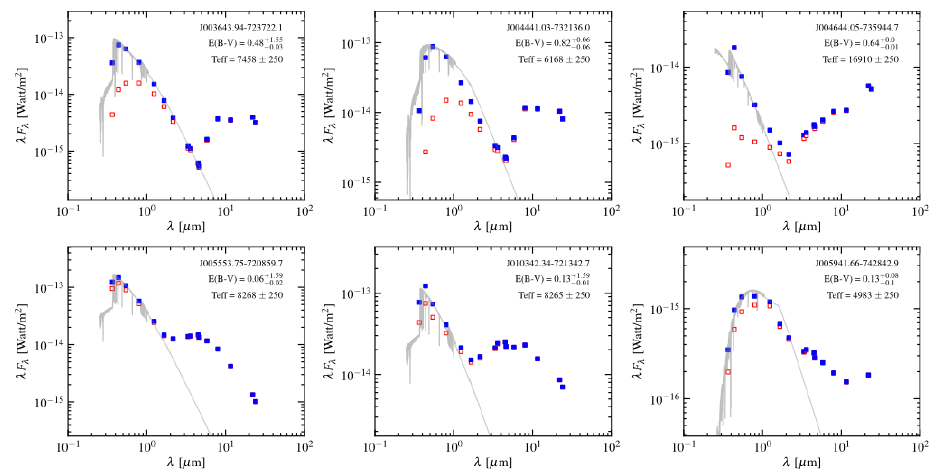
Figure 1. Sample spectral energy distributions (SEDs) of post-AGB stars. The top row represents examples of shell-type SEDs, typical for single stars. The bottom row represents examples of disc-type SEDs, typical for binary post-AGB stars with circumbinary disks. Figure adapted from